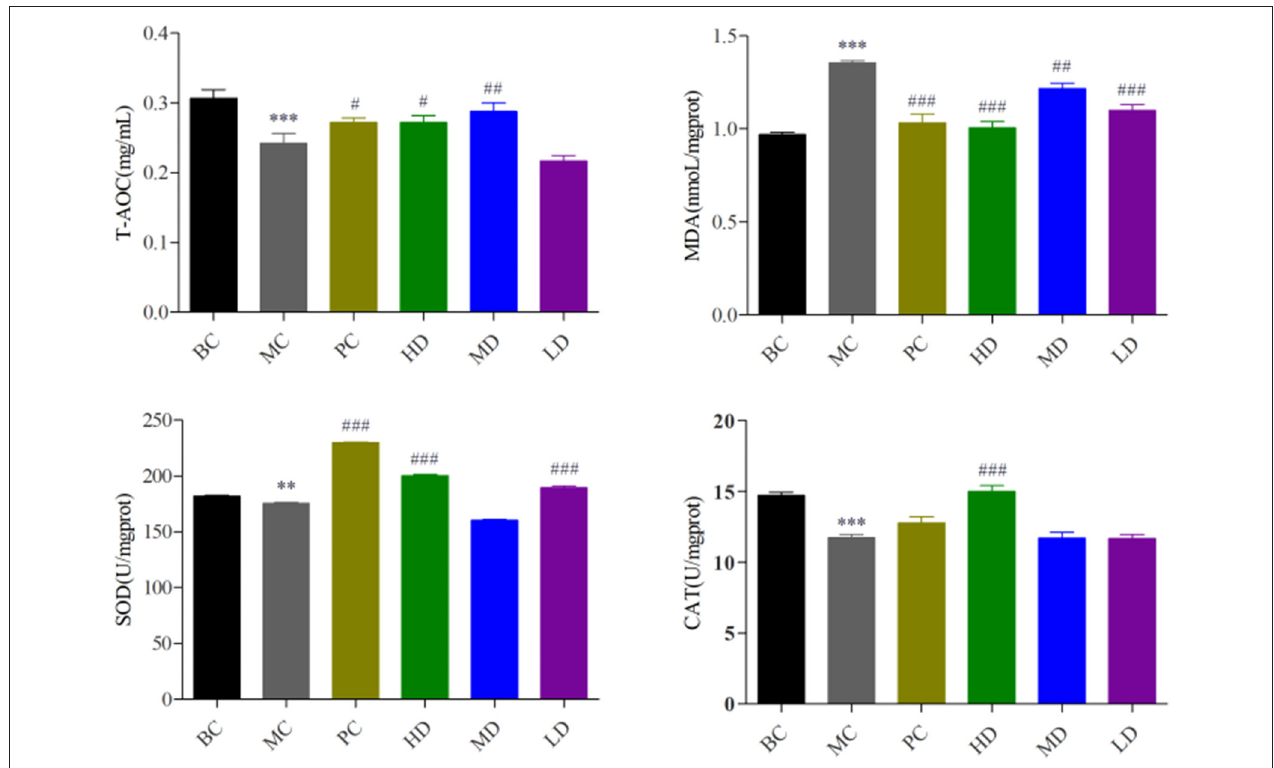
FIGURE 2 | Effect of F. velutipes polysaccharide on antioxidant capacity of mice. Compared with BC group: *** P < 0.001, ** P < 0.01; Compared with MC group: ### P < 0.001, ## P < 0.01, # P < 0.05.